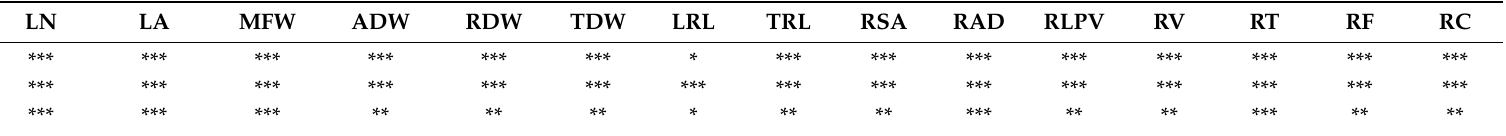
Table 2. The analysis of variance across the treatments of carbon dioxide concentration CO 2 , temperature., UV-B radiation, and two crops (kale and mustard), and their interactions on kale and mustard root and shoot growth and developmental traits, plant height (PH), mainstem leaves (LN), whole plant leaf area (LA), marketable fresh weight (MFW), aboveground dry weight (ADW), root dry weight (RDW), total plant dry weight (TDW), the longest root length (LRL), total root length (TRL), root surface area (RSA), average root diameter (RAD), root length per volume (RLPV), root volume (RV), root tips (RT), root forks (RF), and root crossings (RC).